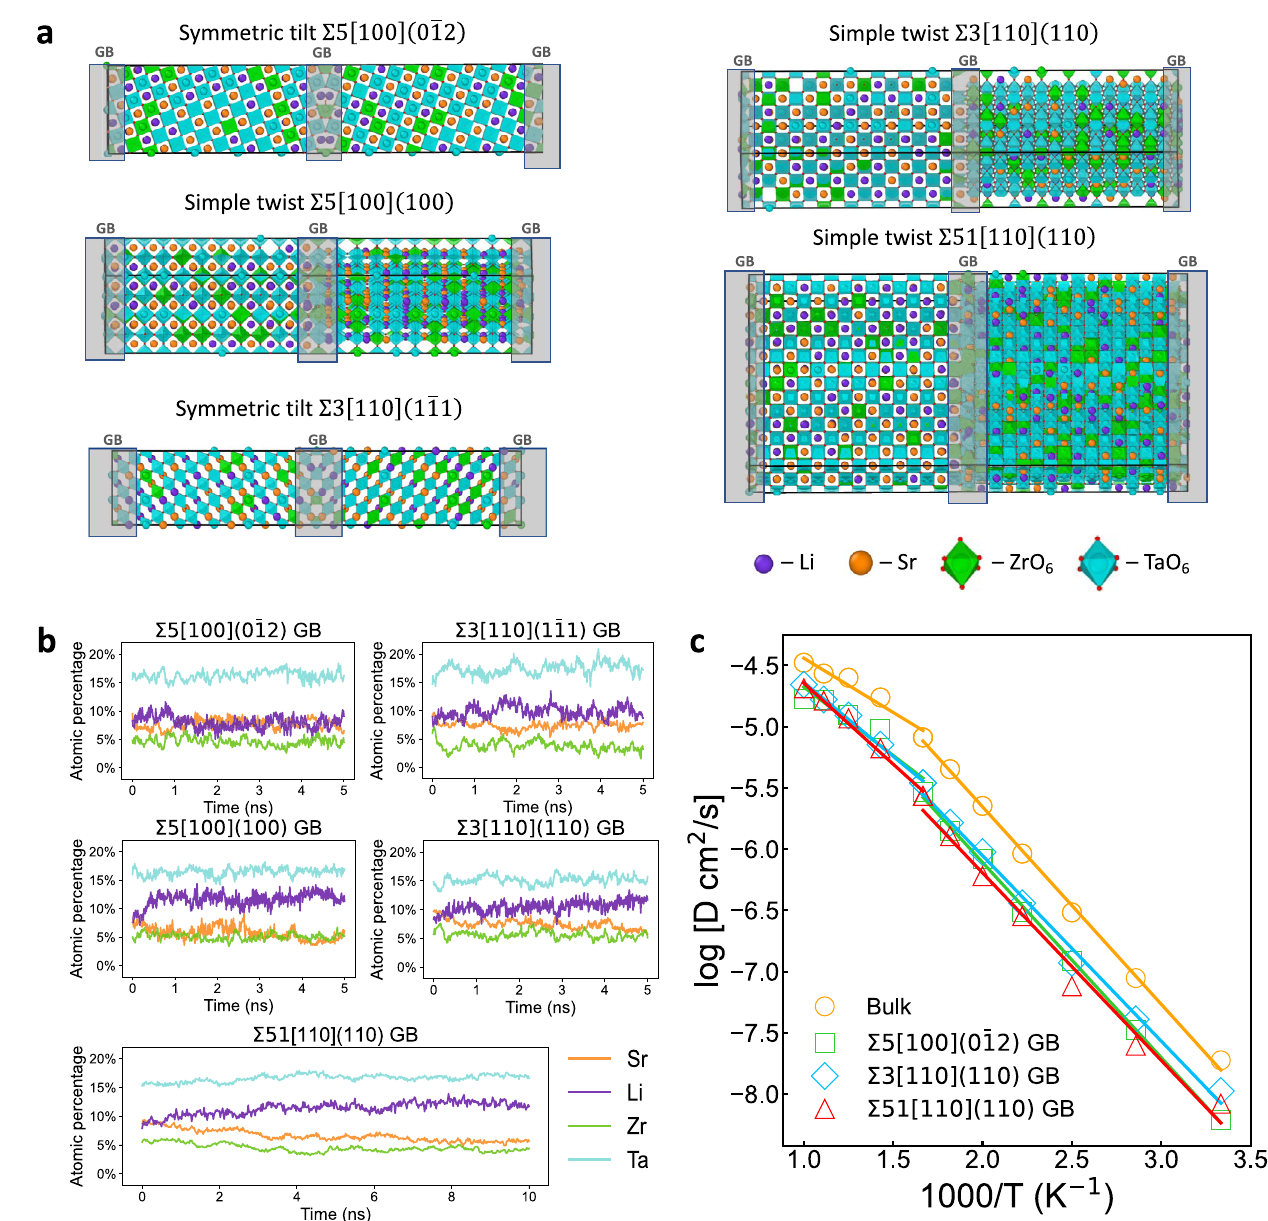
Fig. 4 | Local composition and Li + diffusion at low-sigma and high-sigma GBs. a The structures of the four low-sigma and the one high-sigma GB models, where the GB orientations and the GB regions located at the center and edge of the cells were labeled. GB thickness was de fi ned as two or four times of the interplanar distance between GB planes with a general requirement of d GB >5Å. The exact geometricinformationofthoseGBmodelswasprovidedinSupplementaryTable3.